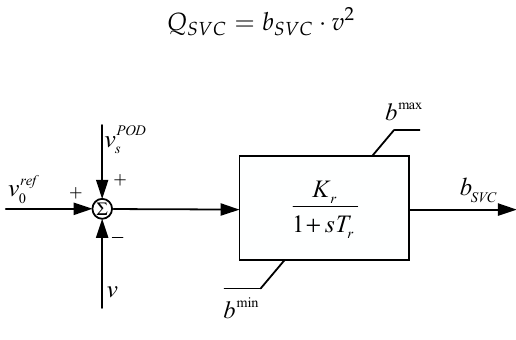
Figure 2. S tatic var compensator (SVC) regulator structure.